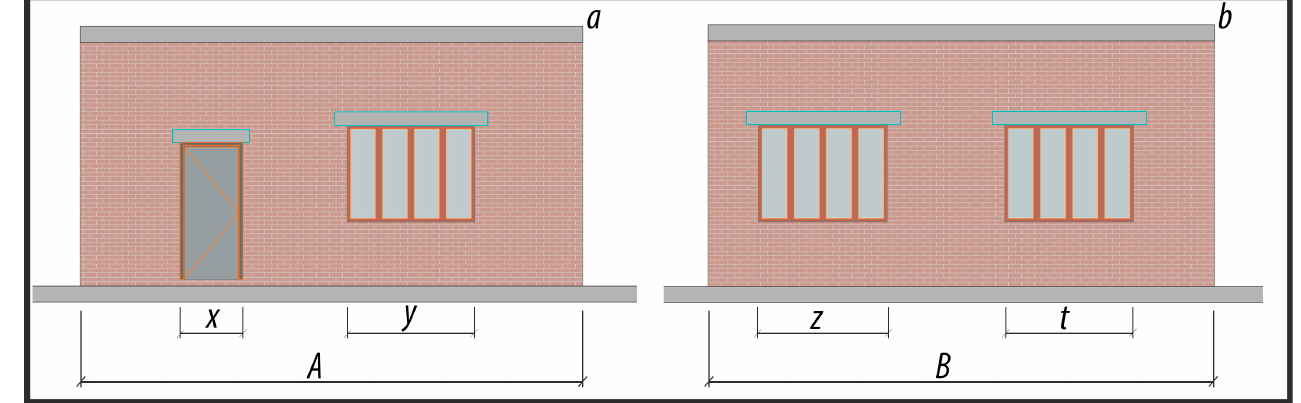
Figure 11. Necessary measurements to determine the insufficient amount of wall: ( a ) Front facade, ( b ) Side facade. Table 7. Parameters for calculating the wall quantity.